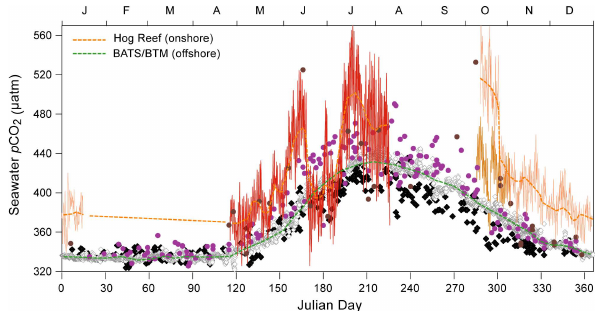
Fig. 4. Annual composite and comparison of surface seawater p CO 2 data (µatm) collected over the last twelve years from the coral reef of Bermuda and offshore in the North Atlantic Ocean at BATS and the Bermuda Testbed Mooring (BTM). All seawater p CO 2 datasets have been adjusted to the year 2006 using the long- term trend of +1.7 µatmyear − 1 observed at the BATS site in the North Atlantic Ocean from 1983–2006 (Bates, 2007). Coral reef seawater p CO 2 datasets include: (1) surface seawater p CO 2 from October 2002 to January 2003 collected hourly at Hog Reef us- ing a CARIOCA buoy (red line); (2) surface seawater p CO 2 from Fig. 3. Relationship between in situ skeletal growth rate of D. April 2002 to September 2003 hourly at Hog Reef using a CAR- labyrinthiformis (i.e., G diploria ) at Hog Reef against mean [CO 2 − ], 3 IOCA buoy (peach line); (3) surface seawater p CO 2 from Octo- (cid:127) aragonite , temperature and light conditions observed at Hog Reef. ber 1998 to November 1998 hourly at Hog Reef using a CARI- Skeletal growth rates are expressed either as mgCaCO 3 g − 1 d − 1 OCA buoy (orange line) (Bates et al., 2001); (4) surface seawater (black square) or as skeletal growth rate per unit surface area p CO 2 (brown closed circles) calculated from surface DIC and al- (mgCaCO 3 cm − 2 d − 1 ; open diamond). (a) Relationship between kalinity samples collected at Hog Reef from July 2002 to Novem- in situ skeletal growth rate of D. labyrinthiformis and average ber 2003; (5) daily mean surface seawater p CO 2 (purple closed cir- [CO 2 − ] (observed at Hog Reef during the concurrent skeletal cle) collected along the southeastern terrace and rim coral reefs of 3 growth rate measurement time period.) Regression statistics were: the North Lagoon, Bermuda, from the R/V Weatherbird II during 75.77x+ 184.2, r 2 =0.68 (skeletal growth rate per colony weight) ∼ 150 cruises between 1994 and 1998. Offshore seawater p CO and 49.30x+ 183.3, r 2 =0.69 (skeletal growth rate per unit sur- datasets include: (6) surface seawater p CO 2 (grey open diamond) face area). (b) Relationship between in situ skeletal growth rate from November 2005 to December 2006 collected every 3h at the of D. labyrinthiformis and average (cid:127) aragonite observed at Hog BTM site [C. L. Sabine and N. R. Bates, unpub. data] and; (7) daily Reef during the concurrent skeletal growth measurement time pe- mean surface seawater p CO 2 (black closed diamond) collected ev- riod. Regression statistics were: 0.976x+ 2.65, r 2 =0.68 (skeletal ery 2min at the BATS site from the R/V Weatherbird II during growth rate per colony weight) and 0.629x+ 2.65, r 2 =0.68 (skele- ∼ 150 cruises between 1994 and 1998 (Bates, tal growth rate per unit surface area). The 95% confidence lev- els for the zero skeletal growth intercept was 2.22–3.08 and 2.21– 3.08, respectively. (c) Relationship between in situ skeletal growth rate of D. labyrinthiformis and temperature ( ˚ C) observed at Hog Reef during the concurrent skeletal growth measurement time pe- riod. Regression statistics were: 13.44x+ 17.36, r 2 =0.28 (skele- tal growth rate per colony weight) and 9.655x+ 16.56, r 2 =0.35 (skeletal growth rate per unit surface area). (d) Relationship be- tween in situ skeletal growth of D. labyrinthiformis and average light (Wm − 2 ) observed at Hog Reef during the concurrent skele- tal growth measurement time period. Regression statistics were: 6617.8x+ 2001.4, r 2 =0.27 (skeletal growth rate per colony weight) and 3791.8x + 2281.1, r 2 =0.21 (skeletal growth rate per unit sur- face area).